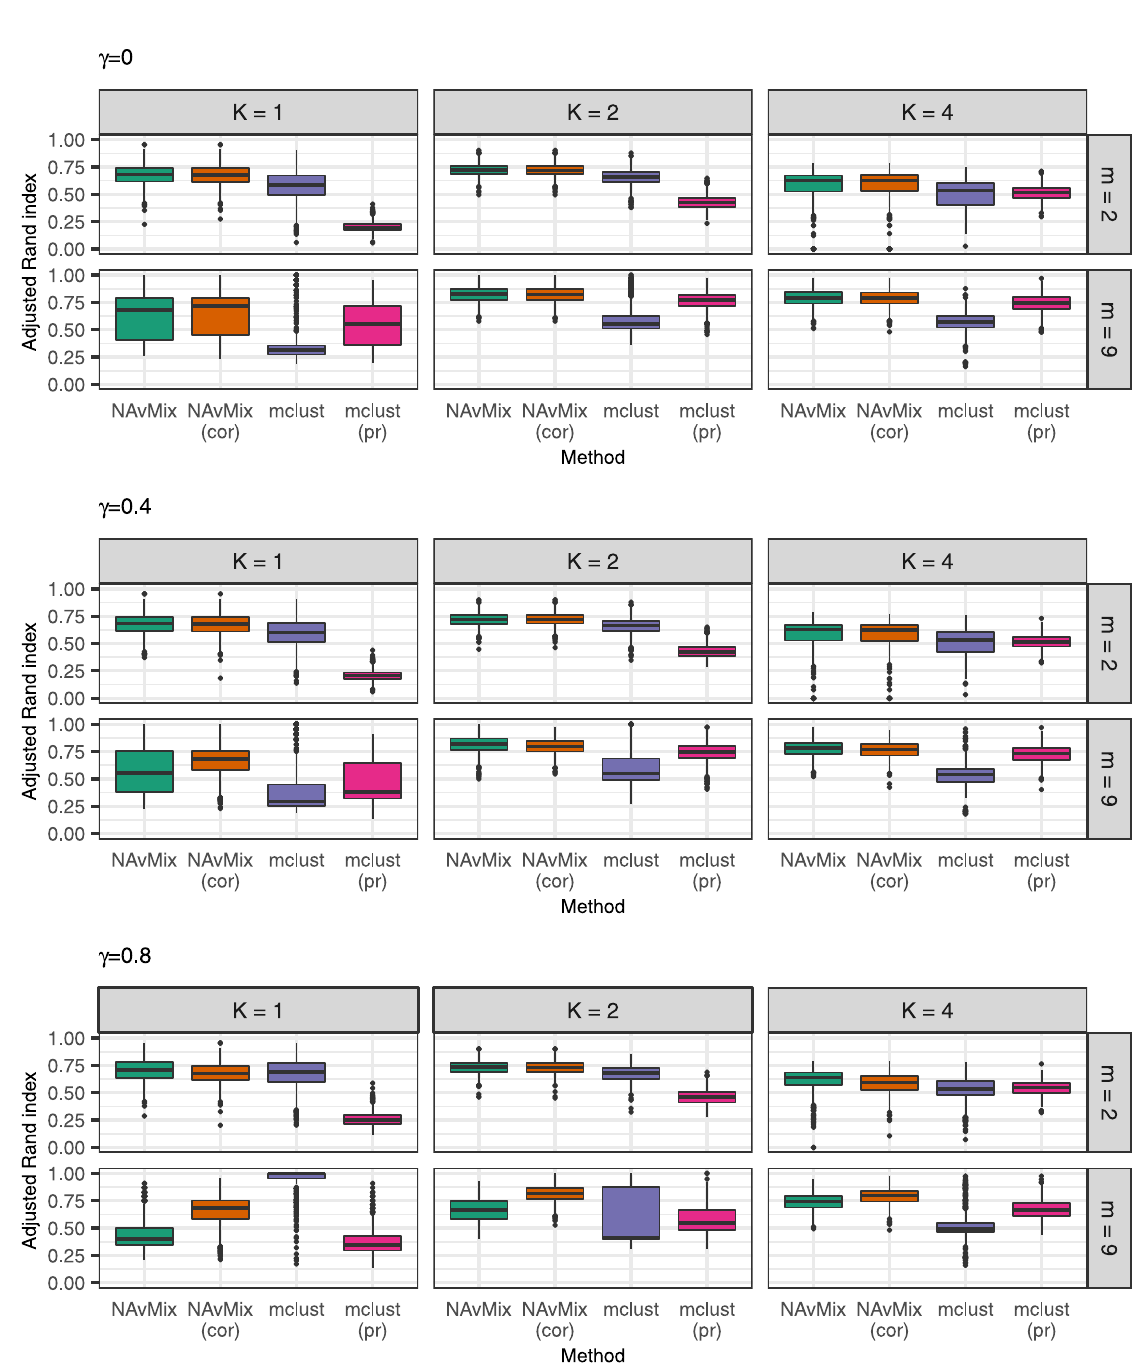
Fig 2. Comparison of methods in the simulation study. Boxplots of the adjusted Rand index for each scenario using NAvMix, NAvMix incorporating trait correlation estimates (cor), mclust, and mclust using proportional associations (pr).